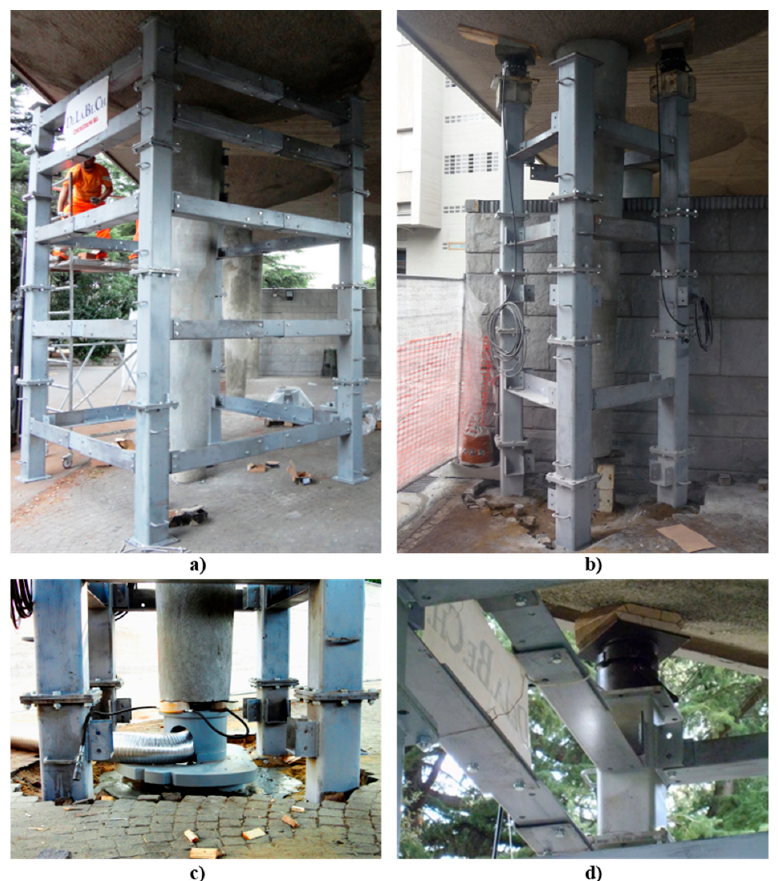
Figure 10. Different lifting steel frames: ( a , b ) the four- and three-columned ones, respectively, ( c ) base detail of the lifting frame, and ( d ) adjustment of the hydraulic jack head on the inclined surface of the mushroom column.